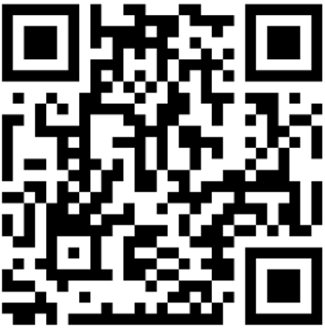
Figure 7. QR code—all commands of Stata that were used in this investigation.